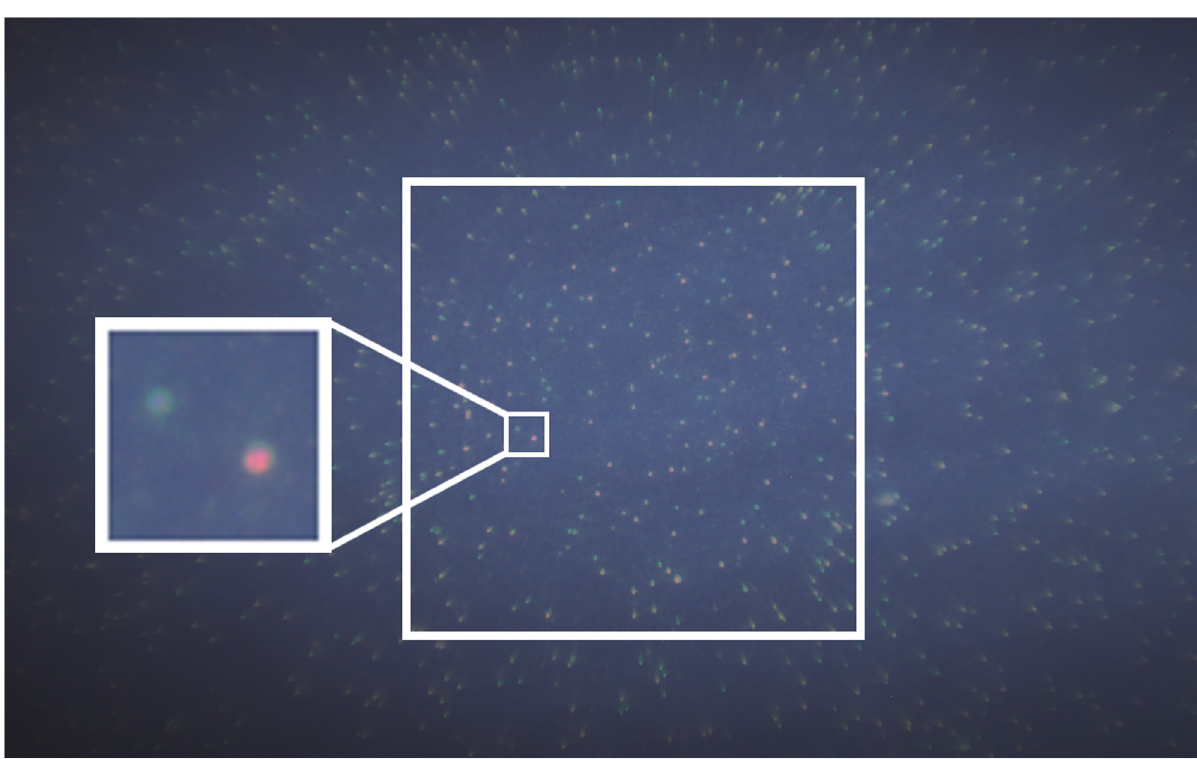
Fig 3. Fluorescence image of WBCs stained with AO. (a) Image taken using the 280 nm excitation source with an exposure time of 500 ms and detector gain of 0 dB without excitation or emission filters. The large, central white box represents the 1 mm x 1 mm FOV where WBCs are in focus. Insert image shows a pair of arbitrarily selected WBCs. (b) Image of the same FOV with an inexpensive absorption foil, which served as an emission filter, that only allowed the fluorescence signal from the WBCs. Color images were reconstructed from raw intensity values given by the Bayer mask of the